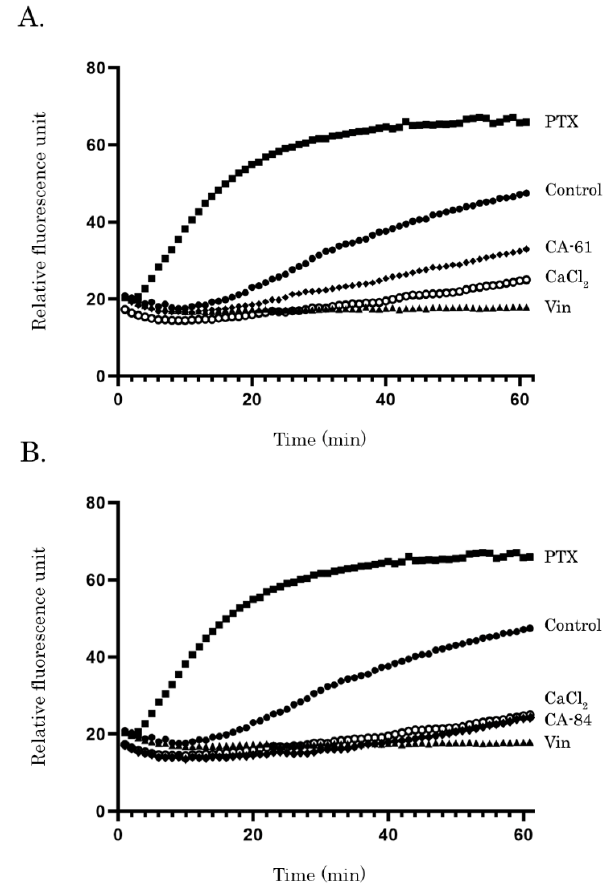
Figure 6. Dynamics of tubulin polymerization in samples treated with CA-61 ( A ) and -84 ( B ). Tubulin was also incubated with DMSO (control), Paclitaxel (PTX), Vinblastine (Vin), and CaCl 2 at 37 °C, and absorbance was assessed every min for 1 h. A shift of the curve to the upper left of the control (DMSO) represents an increase in polymerized microtubules. A shift to the bottom right of the graph reflects the decrease in the rate of tubulin